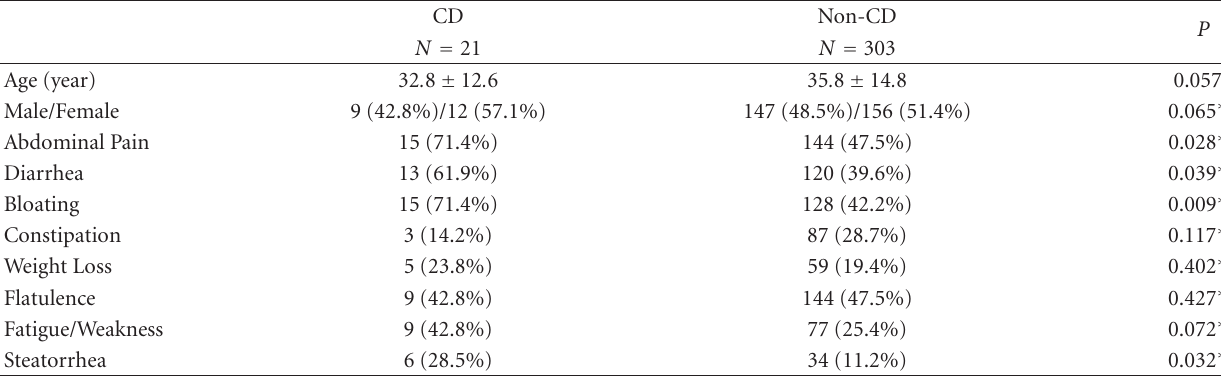
Table 3: Comparison of symptoms between patients with and without